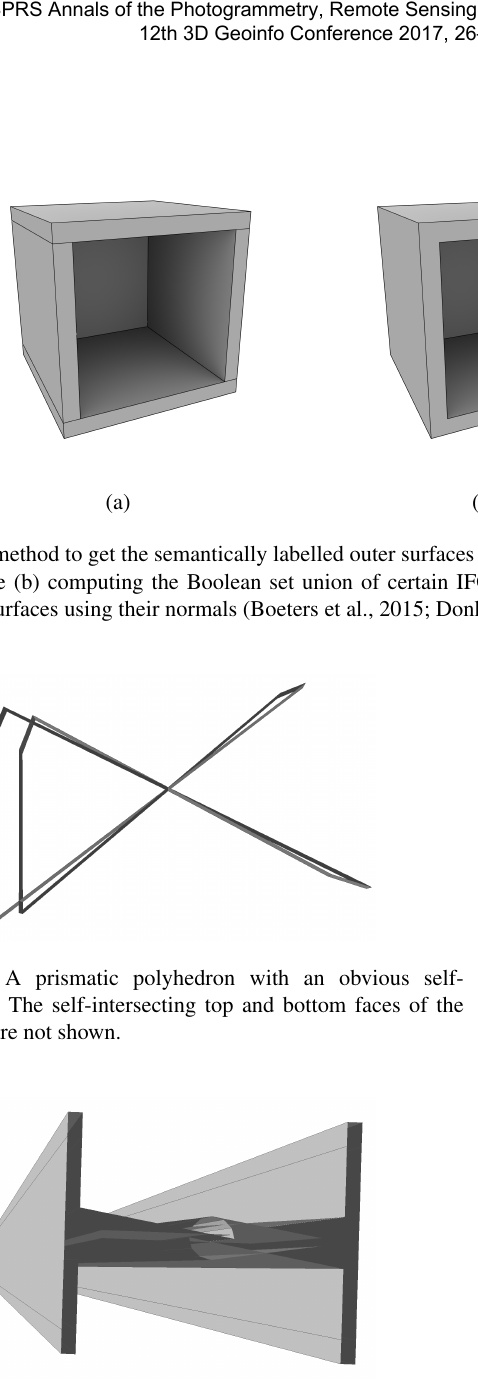
Figure 8. A self-intersecting representation of a beam.